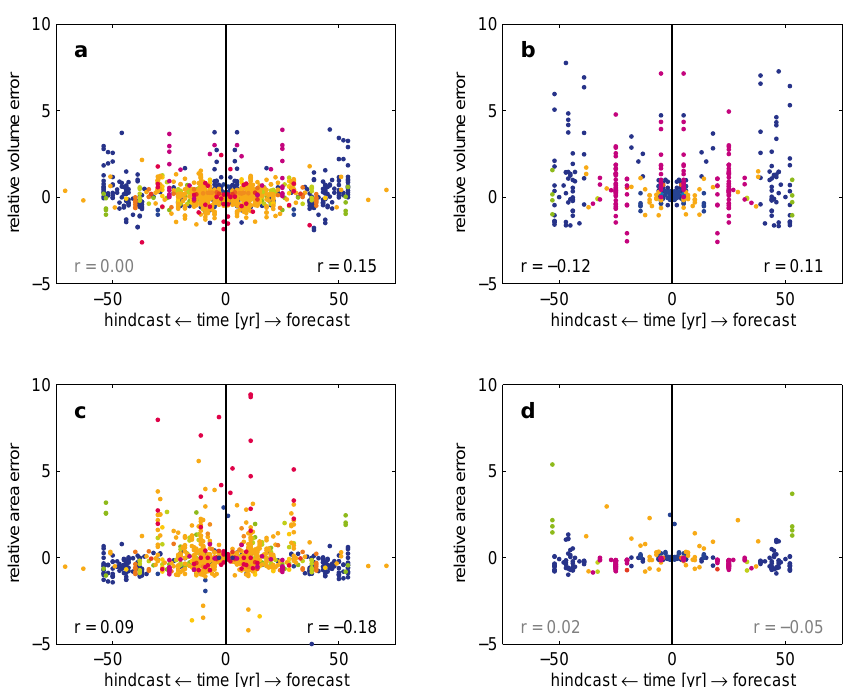
Fig. 15. Validation of temporally integrated modeled volume changes and surface areas, and propagated model errors; (a) relative volume errors of non-calving glaciers as a function of time covered by geodetical measurement, negative indicates model in hindcast mode, positive in forecast mode; (b) relative volume errors of calving glaciers as a function of time covered by geodetical measurement; (c) relative surface area errors of non-calving glaciers as a function of time covered by geodetical measurement; (d) relative surface area errors of calving glaciers as a function of time covered by geodetical measurement; numbers indicate correlations (gray/black: below/above 95% confidence